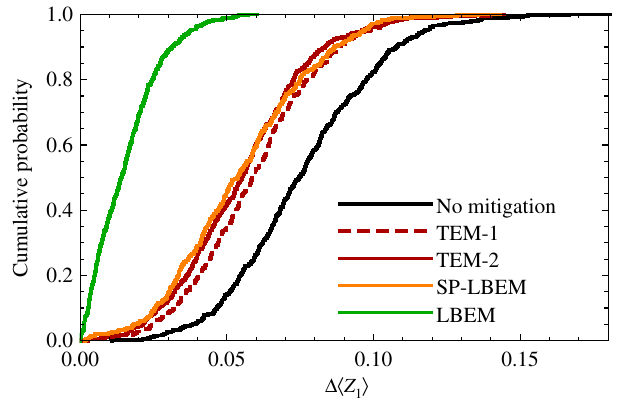
FIG. 17. Empirical cumulative distribution function of esti- mated (cid:7) (cid:10) Z 1 (cid:2) for 500 pseudorandom circuits with spatially corre- lated dephasing noise. Results for circuits without error mitiga- tion (black), with tomographic error mitigation for k = 1 (dashed red) and k = 2 (red), with a single-parameter learning-based error mitigation (orange), and with a multiparameter learning- based error mitigation (green) are